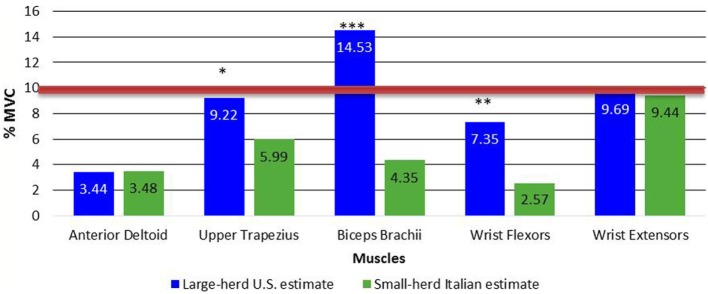
Simple main effects of dairy size × muscle interaction for 50th percentile APDF. Red line indicates limit values that muscle load should not exceed (31). *p = 0.02, **p = 0.004, and ***p < 0.001. APDF, amplitude probability distribution function.